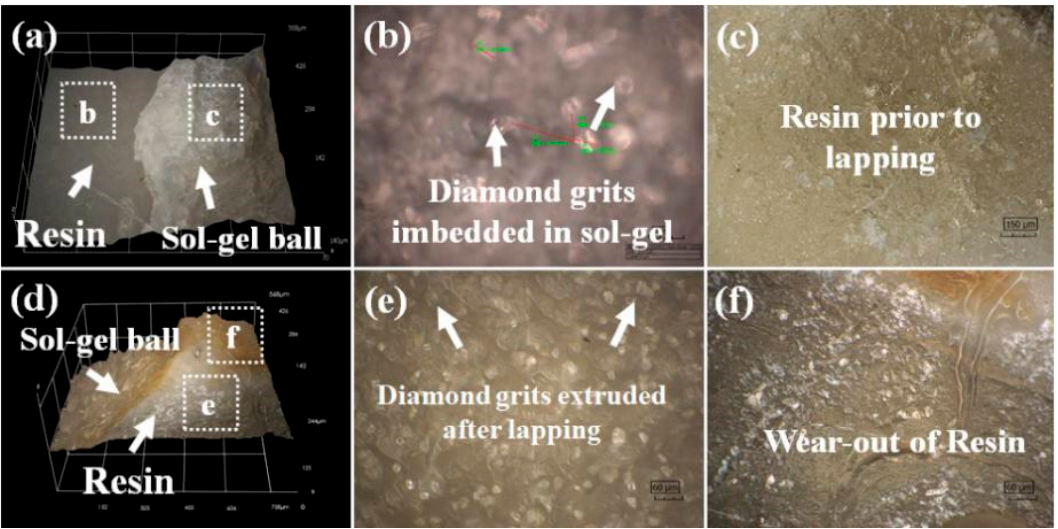
Figure 9. Optical topography of the resin and sol–gel boundary ( a ) as-prepared and ( d ) after lapping for 90 min under a pressing force of 12 kg. ( b ), ( c ), ( e ), and ( f ) were sol–gel balls and resin matrix for 90 min under a pressing force of 12 kg. ( b , c , e , f ) were sol–gel balls and resin matrix manifested from manifested from location marked by white box in ( a ) and ( b ), respectively. location marked by white box in ( a ) and ( b ), respectively.